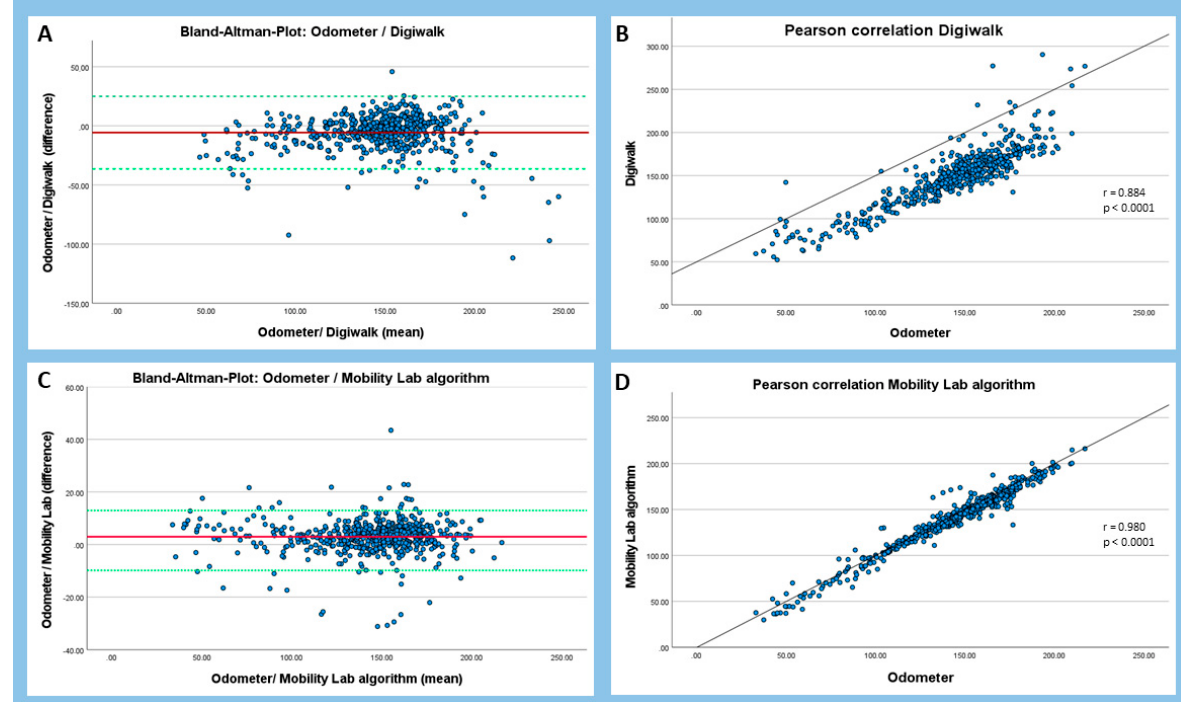
Figure 6. Bland–Altman and Pearson’s correlation plots. ( A ) Bland–Altman plot of the Digiwalk measurement; ( B ) Pearson correlation of the Digiwalk measurement; ( C ) Bland–Altman plot of the Mobility Lab algorithm; ( D ) Pearson correlation of the Mobility Lab algorithm. The red line shows the mean of the differences between the two respective methods, and the dashed green horizontal lines show the upper and lower 95% limits of agreement (=mean ± 1.96 × SD). R = correlation coefficient.